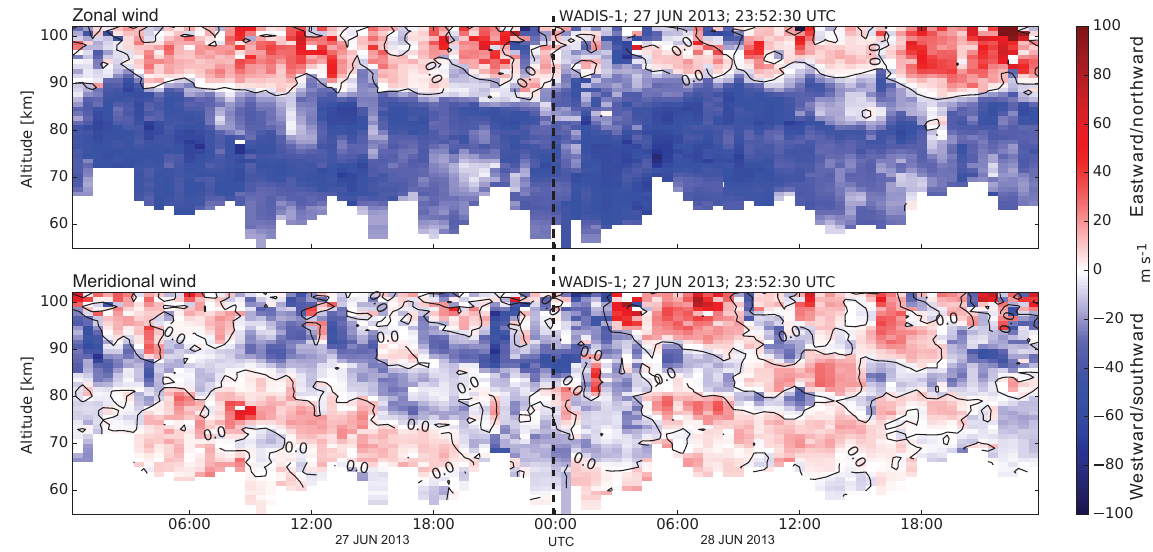
Figure 8. Wind measurements by SAURA-MF radar around WADIS-1 sounding rocket launch. Black isolines mark zero wind.